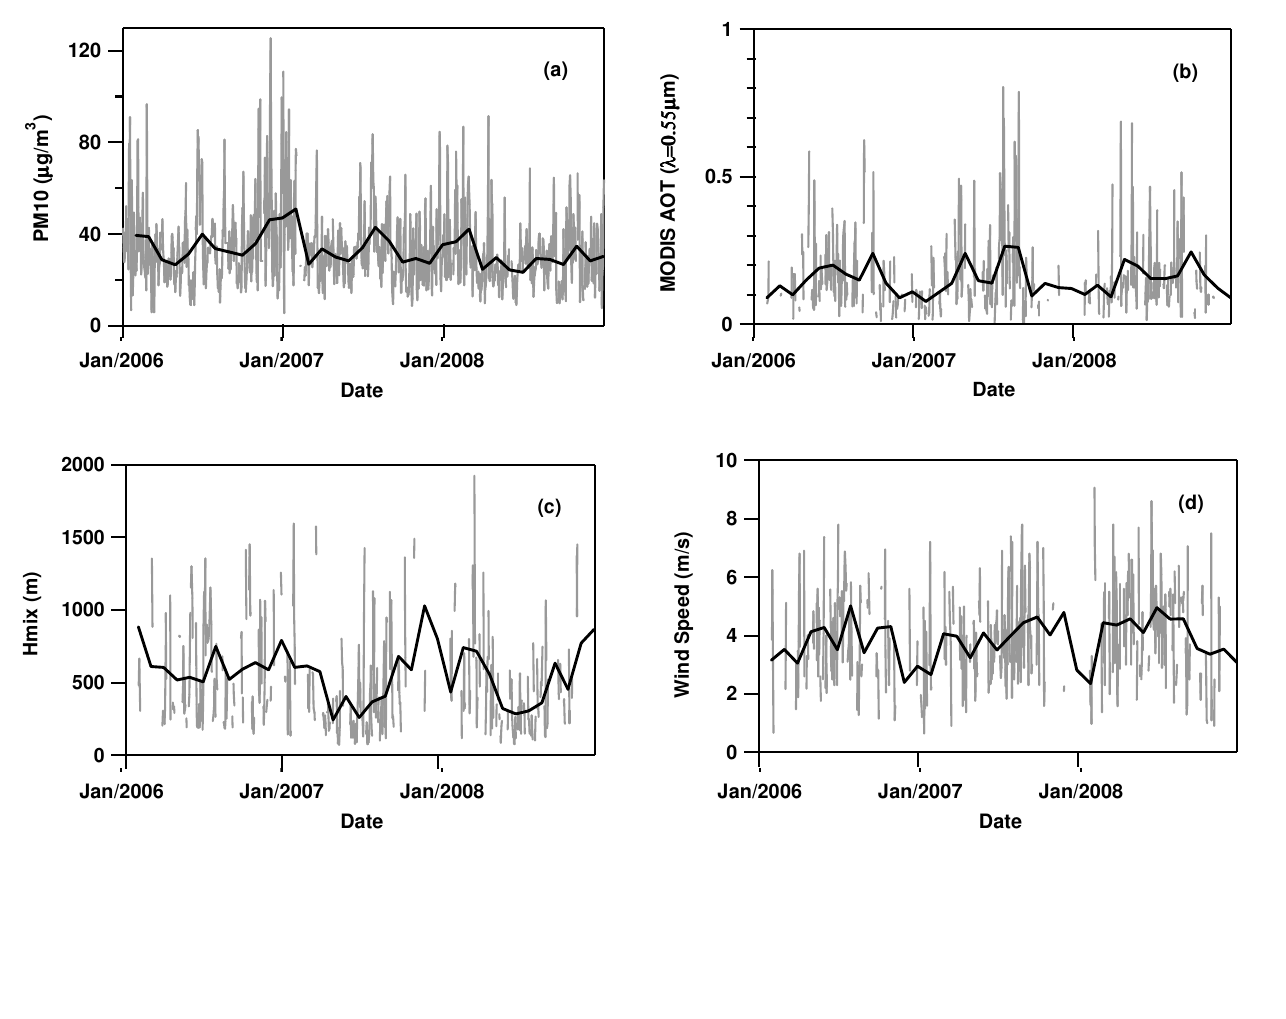
Figure 2. Time evolution of (a) PM10 mass concentrations, (b) MODIS aerosol optical thicknesses (AOT), (c) mean mixing layer heights within 9–15 Universal Time (UT) time interval (Hmix), and (d) mean wind speed values within 9–15 Universal Time time interval (WSav), at Arnesano from 2006 to 2008. Grey lines show daily measurements, black lines show monthly